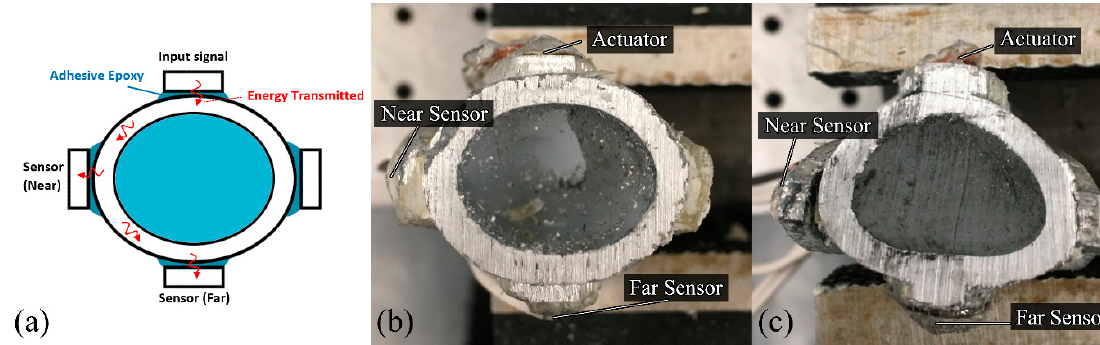
Figure 4. ( a ) Schematic of sensors location and specimen bonded with adhesive epoxy; Oval ( b ) and triangular ( c ) cross-section aluminium specimen with 4-extramedullary struts design, including near and far sensor placements on the struts.